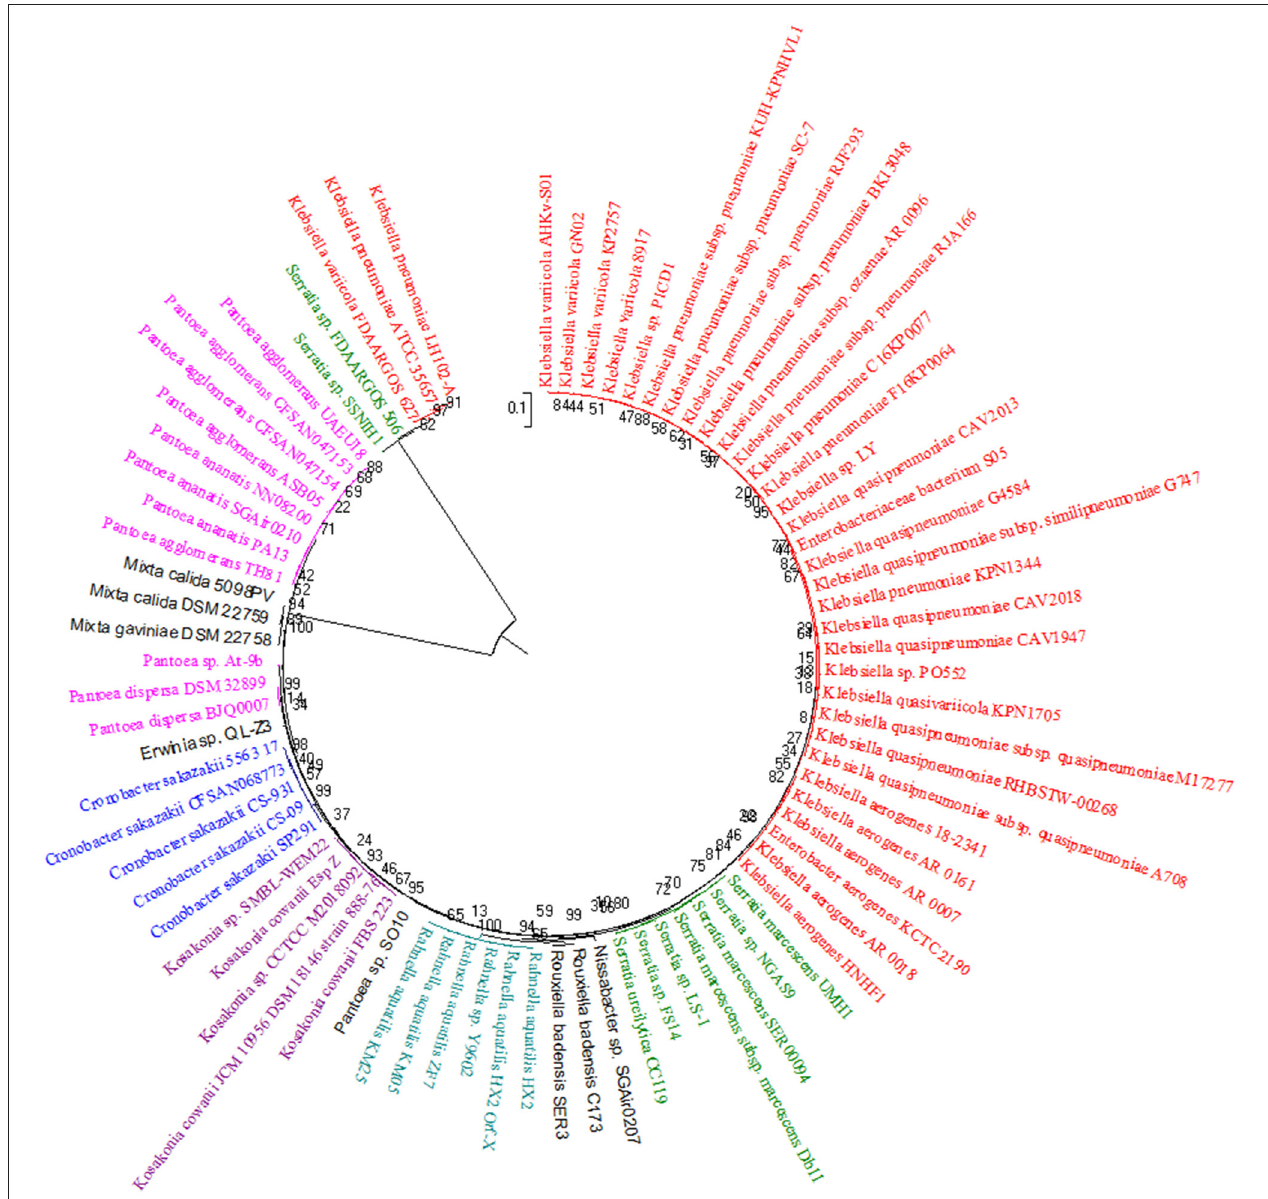
FIGURE 2 | A phylogenetic tree showing the relationship based on 16S rRNA gene sequences among the diverse Gammaproteobacterial groups considered in this study. 16s rRNA gene sequences were aligned with the Clustal W algorithm and an unrooted by the Neighbor-joining Maximum Composite Likelihood (MCL) method (NJ-MCL) using MEGA6.06 software (http://www.megasoftware.net/, Kumar et al., 2008). The bootstrap consensus tree inferred from 1,000 replicates is taken to represent the evolutionary relationship of the taxa analyzed (Felsenstein, 1985). The number in each node indicates the confidence value of that branch after bootstrapping the phylogenetic tree. A uniform rate was used to model evolutionary rate differences among sites. Complete deletion of gaps/missing data was